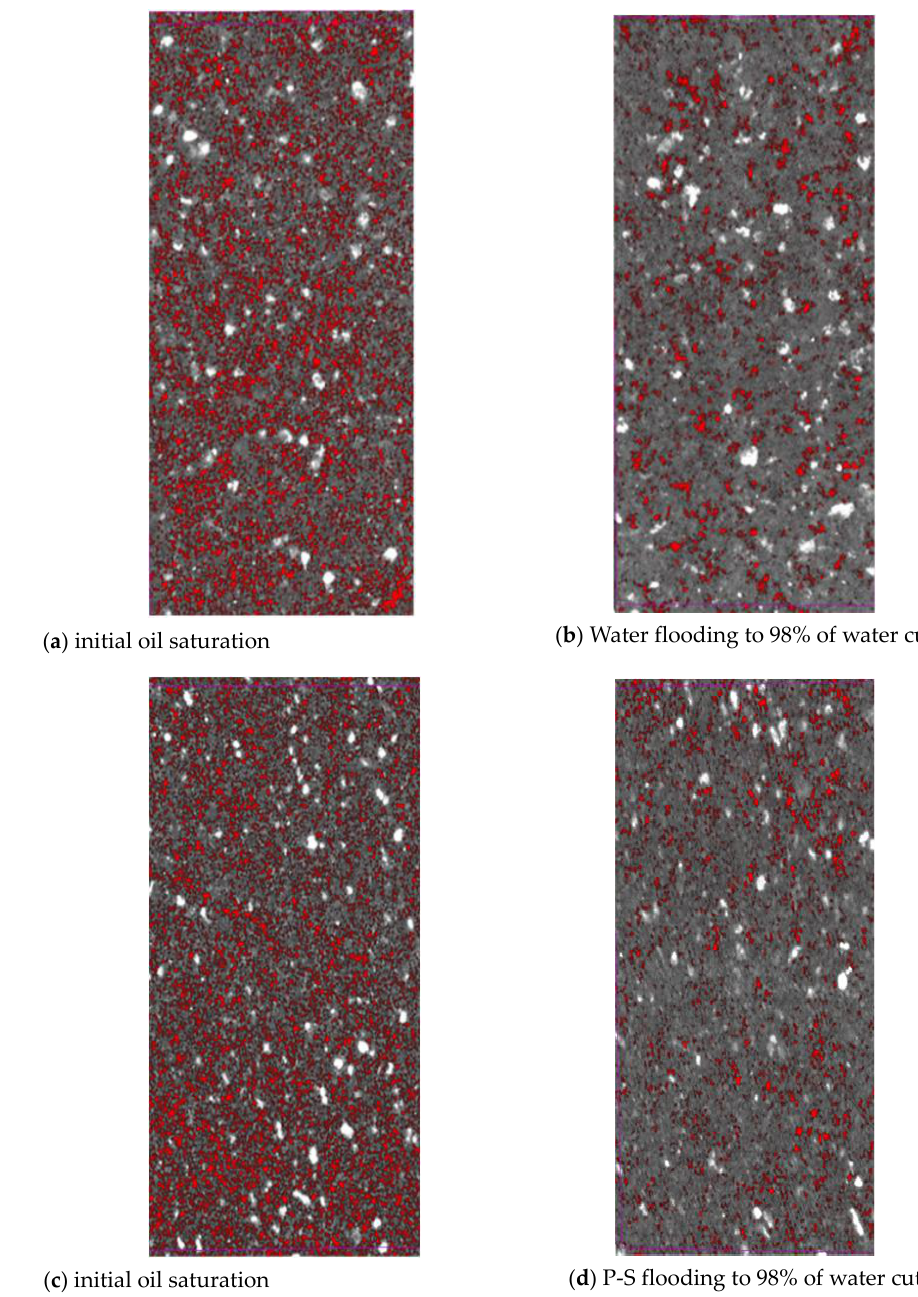
Figure 2. Pore-scale oil distribution after water and P-S flooding of in #2 rock sample.